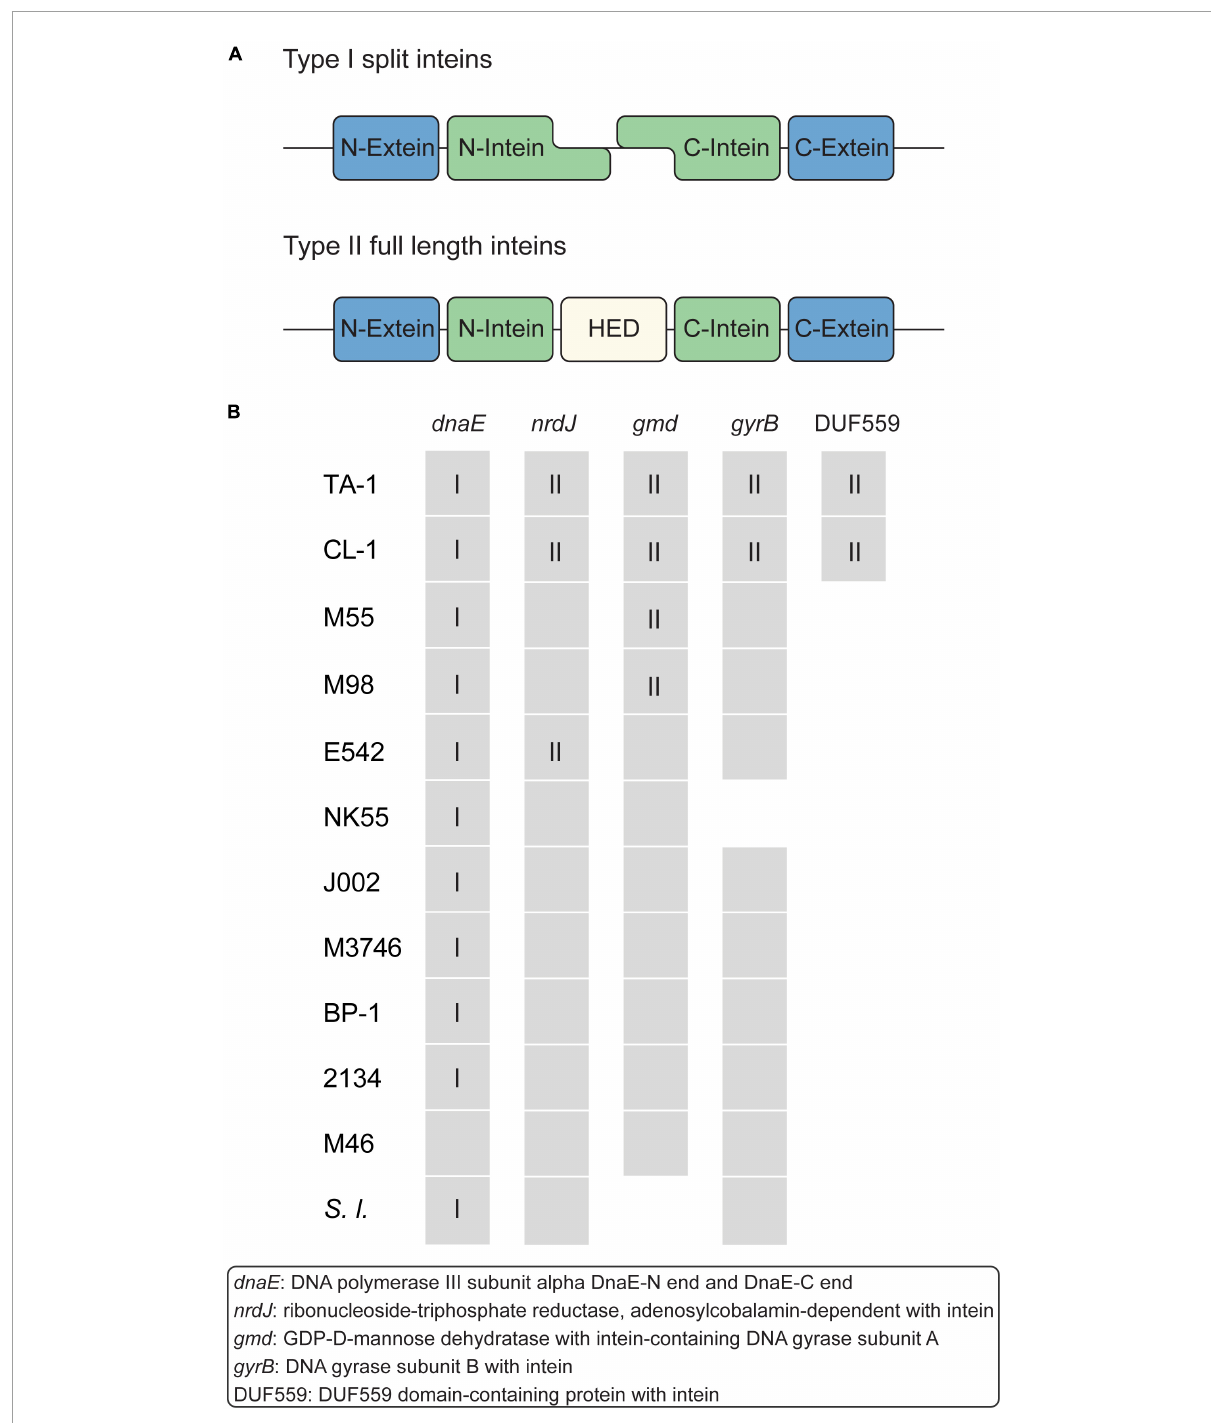
FIGURE5 Intein-containing genes. (A) Structure of type I and II inteins. (B) Distribution of intein-containing genes in strains. Gene presence and absence are indicated as a colored and white background, respectively. For genes that contain inteins, the intein types are indicated by Roman numerals.